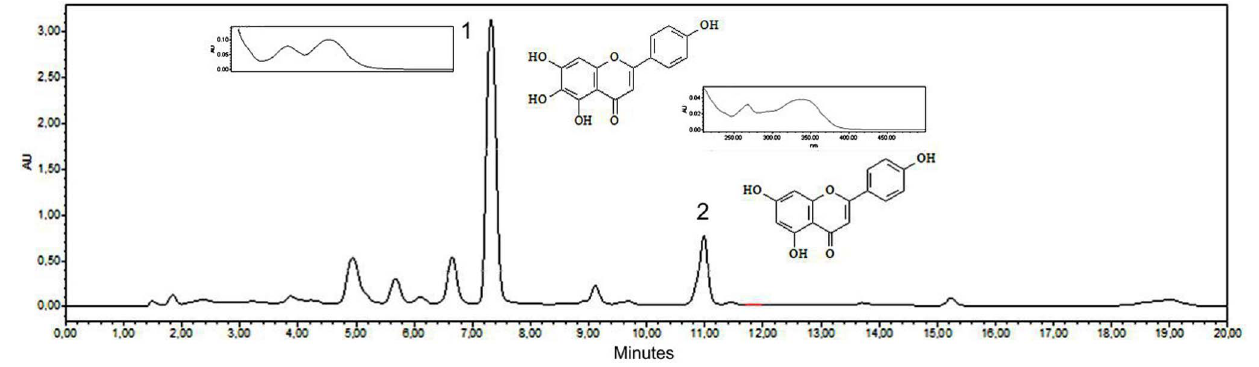
Figure 2. HPLC chromatogram of the Arrabidaeachica extract. Peak 1 (scutellarein) and peak 2 (apigenin).